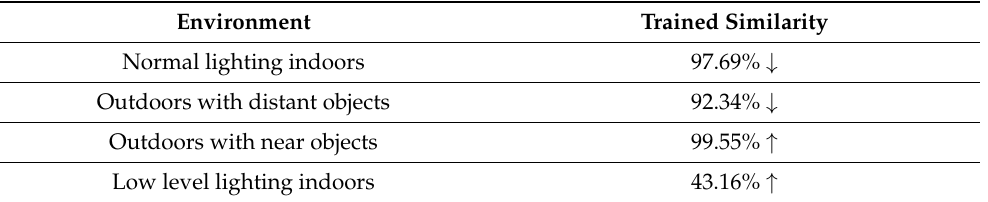
Table 4. Accuracy similarity between the standalone camera system and camera-trained radar